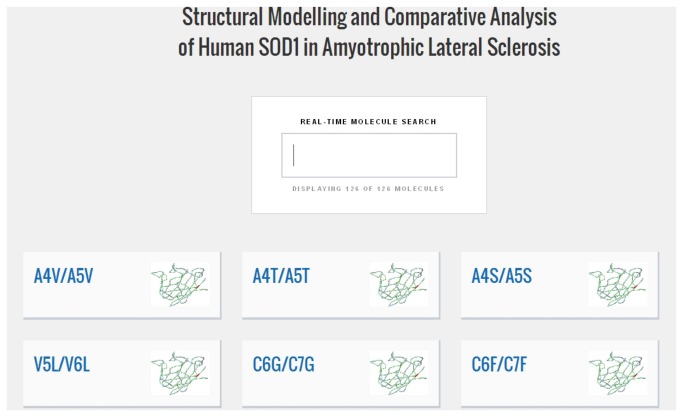
Screenshot of the SOD1 Database web interface for structural modelling and comparative analysis.